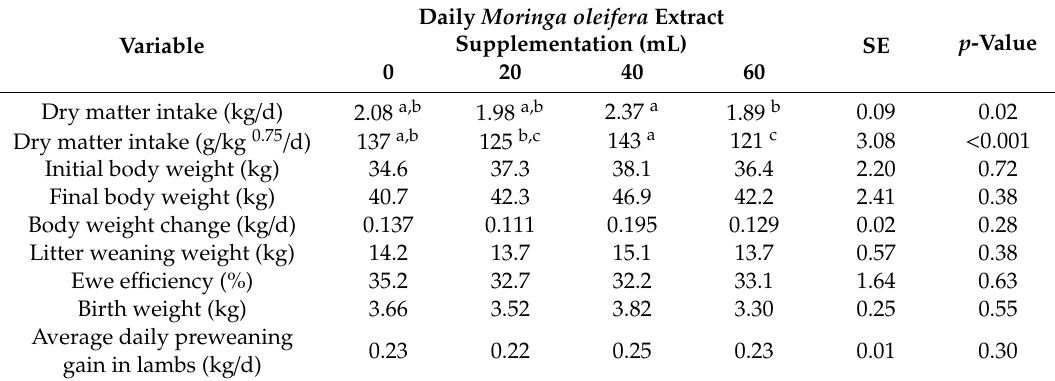
Table 4. Preweaning ewe and lamb performance traits in Pelibuey × Katahdin ewes supplemented with Moringa oleifera leaf